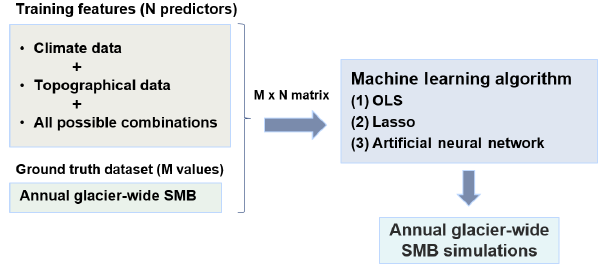
Figure 2. Glacier-wide SMB simulation component workflow. Ma- chine learning models are dynamically created based on training